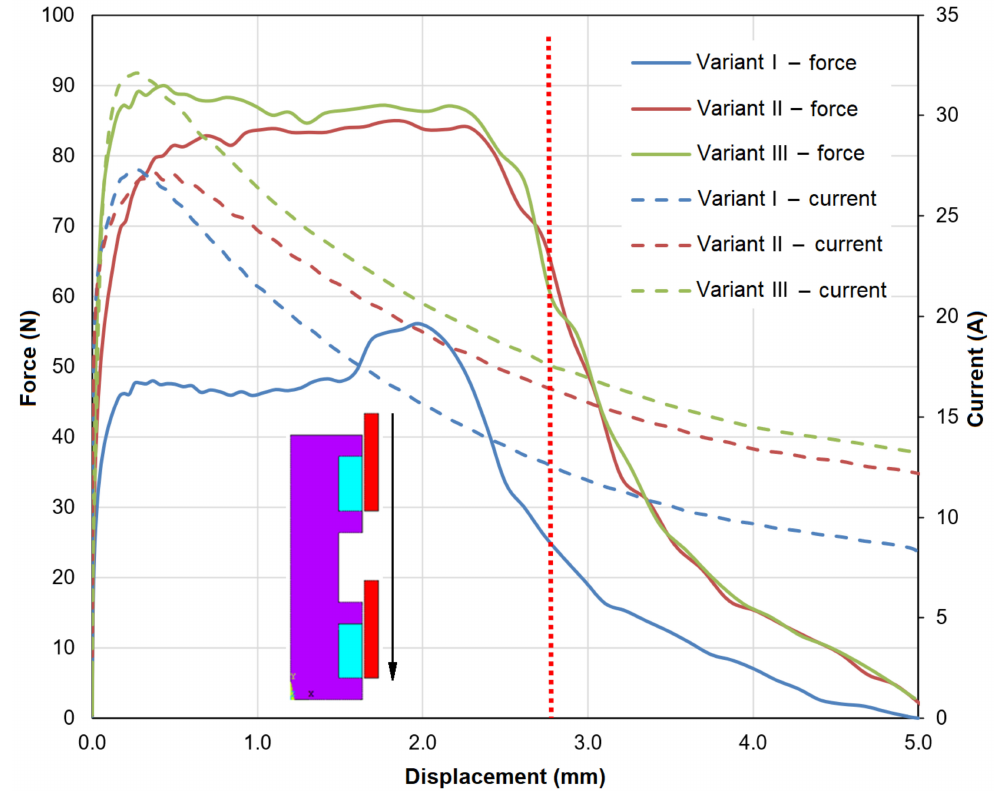
Figure 20. Ponderomotive force and current in the coil depending on the position of the hammer with the characteristic position of the ferromagnetic rings. Juxtaposition of results. Arrow marks the hammer displacement